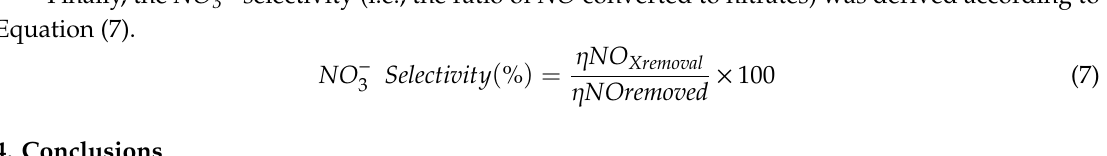
Figure 14. Spectral irradiance profile of the fluorescent light source used.